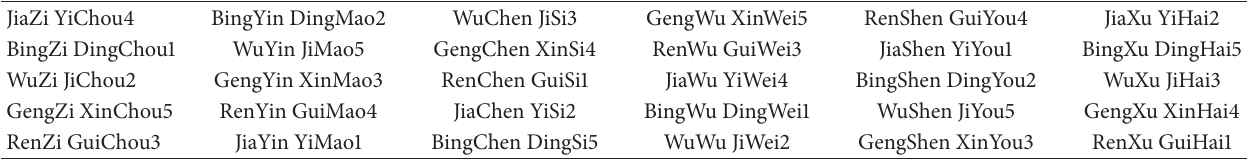
Table 3: New arrangement based on the 12